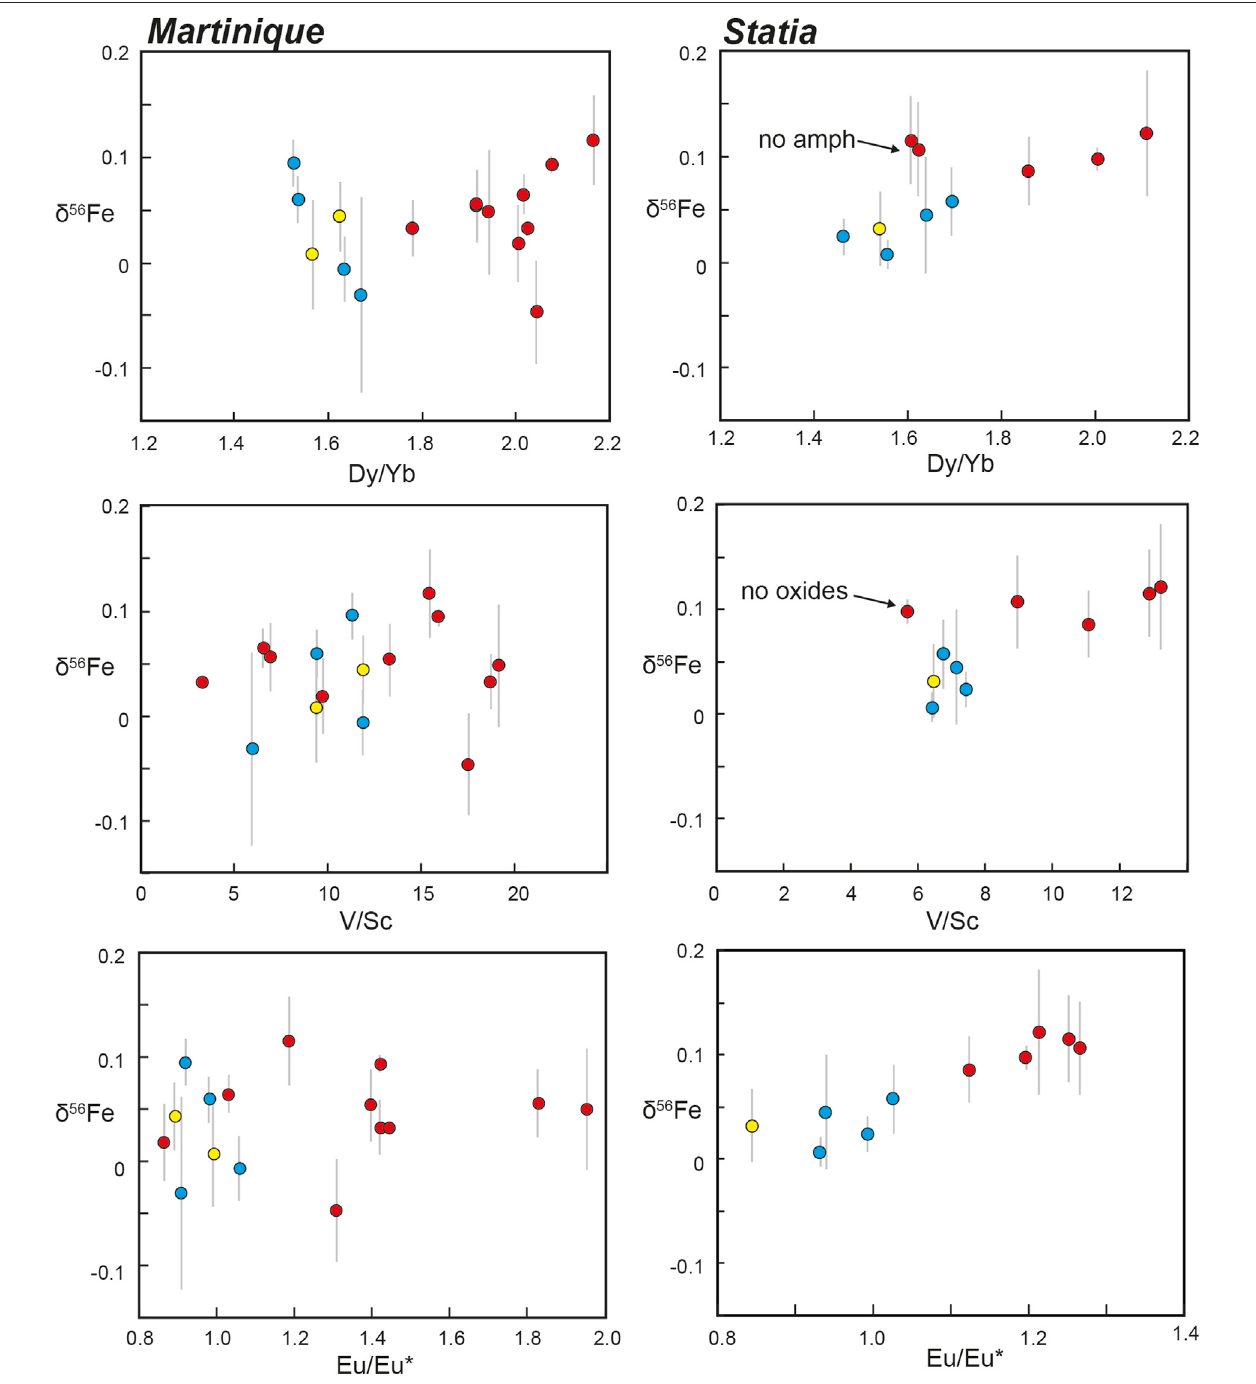
FIGURE5 | Measured δ 56 Fe values versus Dy/Yb, V/Sc and Eu/Eu* ofcumulates (red circles), NCG ’ s (blue circles) and lavas (yellow circles) from Martinique (A – C) and Statia (D – F) .